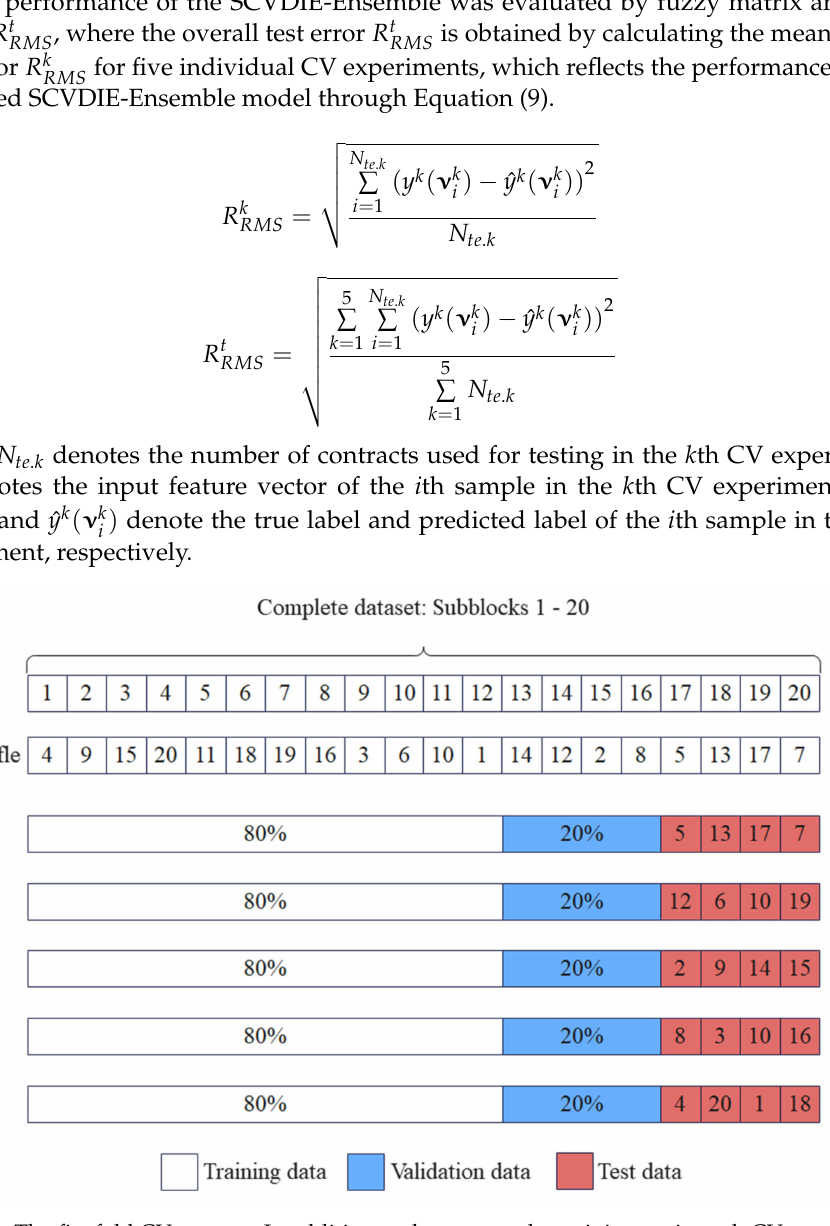
Figure 8. The fivefold CV process. In addition to the test set, the training set in each CV experiment consists of 80% of the dataset, while the remaining 20% is used to construct the validation